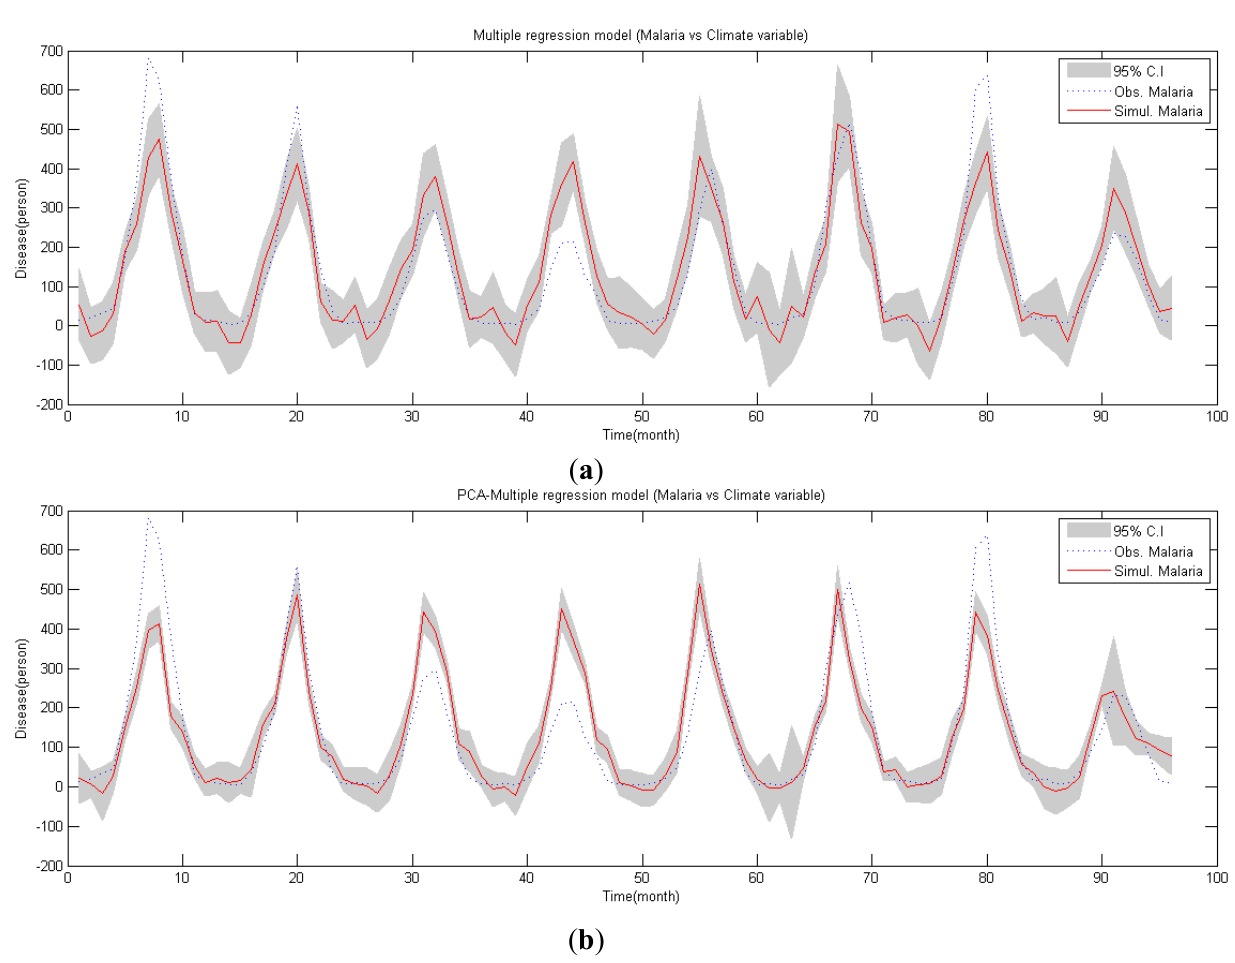
Figure 3. Malaria simulation (2001–2008) ( a ) Malaria simulation by multiple regression; ( b ) malaria simulation by